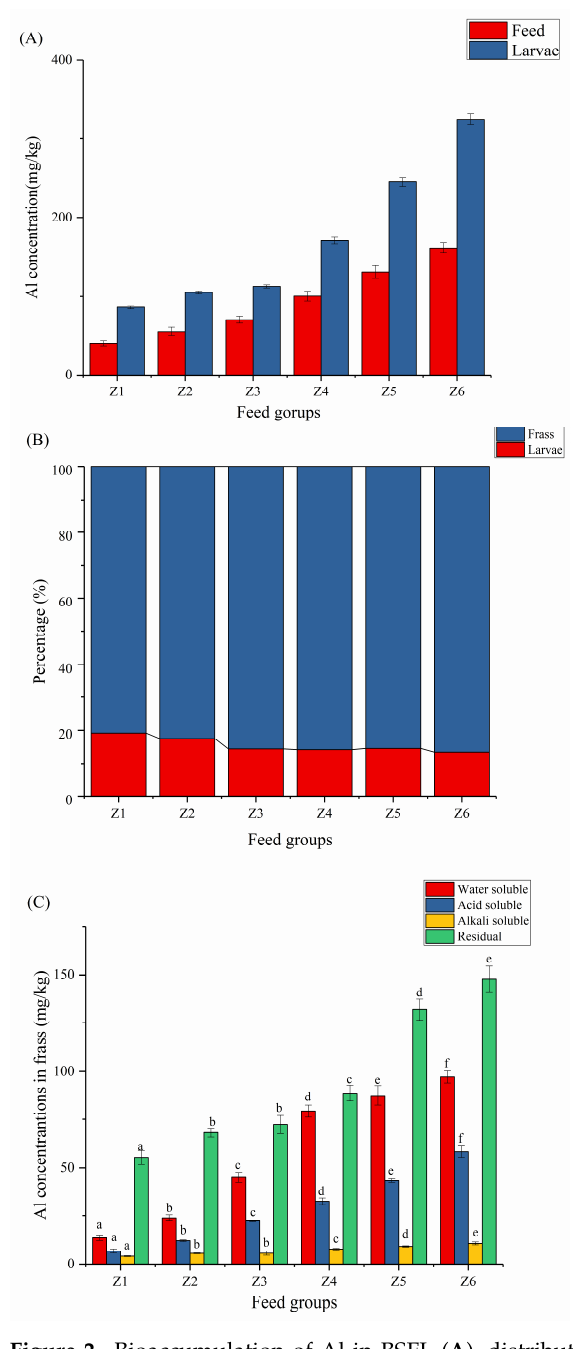
Figure 2. Bioaccumulation of Al in BSFL ( A ), distribution of Al in larvae and frass ( B ), and existing forms of Al ( C ). Different characters indicate a significant difference ( p < 0.05). Z1, Z2, Z3, Z4, Z5, and Z6 represent the 6 experimental groups of 0, 50, 100, 200, 300, and 400 mg/L mixed flocculant, respectively.